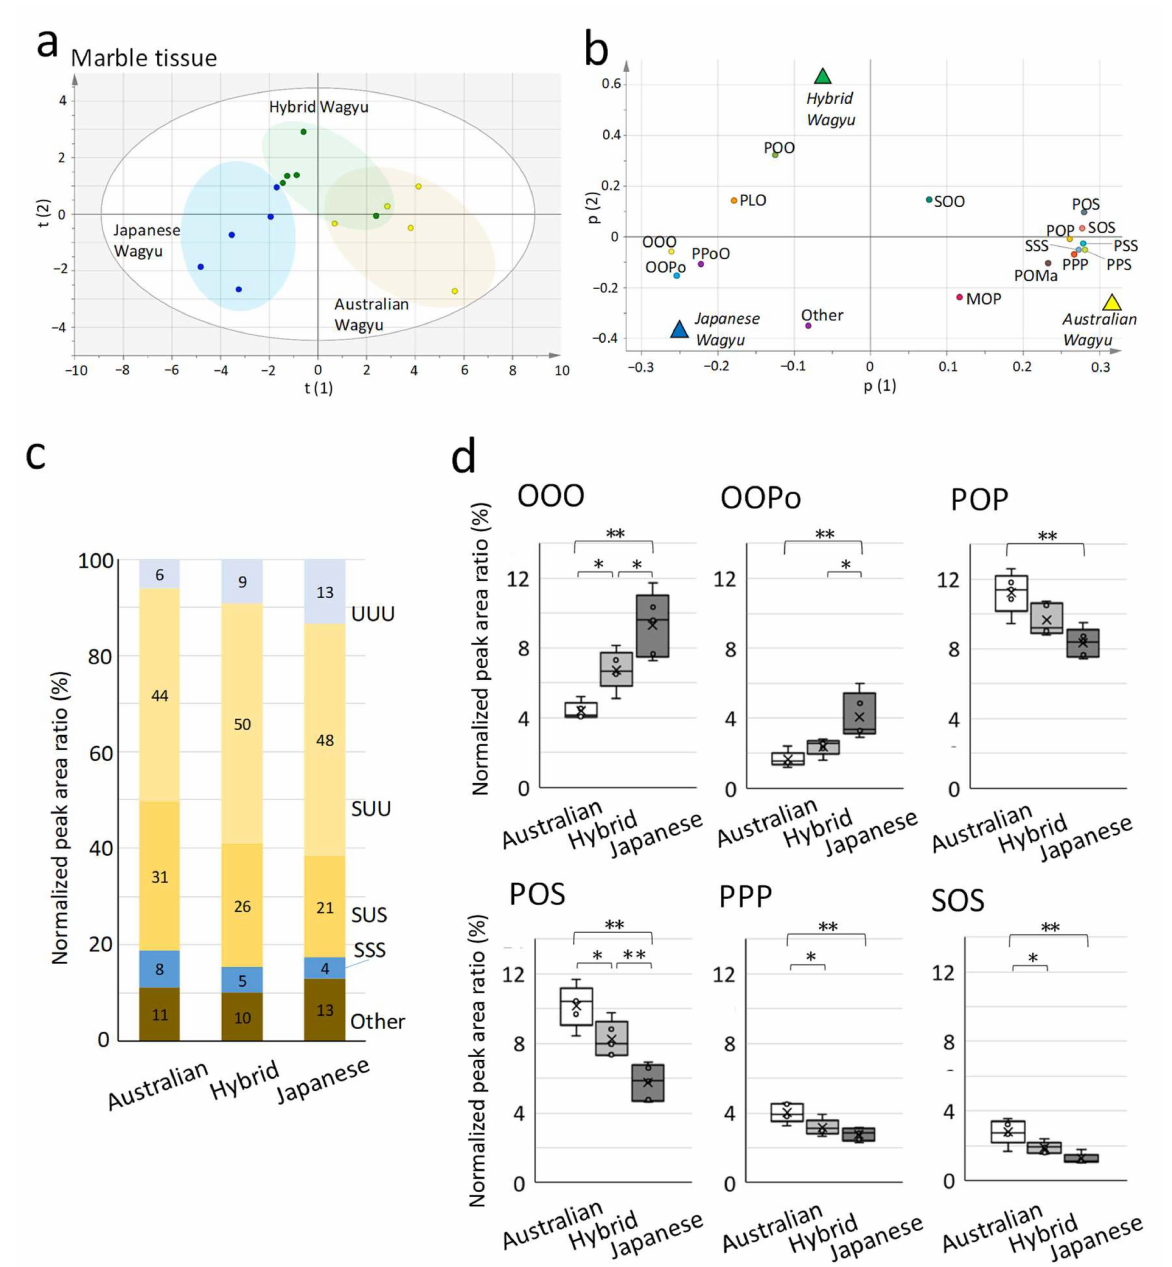
Figure 2. Comparison of triacylglycerides (TG) molecular species among the Wagyu breeds. We used high-performance liquid chromatography to determine the major TGs in Wagyu beef. Marbling tissues from the rib-eye area of the longissimus thoracis muscle (five Australian, five Hybrid, and five Japanese Wagyu) were used. ( a ) The score plot of orthogonal part least-square discrimination analysis (OPLS-DA) illustrated the relationship among Wagyu beef types (scaling, UV). ( b ) Loading plot detailing the relationship between TGs and each Wagyu type (R2X (1) = 0.606; R2X (2) = 0.152). Italicized letters indicate the location of each DA plot (triangles) obtained by OPLS-DA. ( c ) Percentage of unsaturated fatty acids in TGs. Bar graphs present the TG composition of each breed (each Wagyu, n = 5). The three-letter designations indicate the percentage of unsaturated and saturated fatty acids in the TGs. ( d ) Box plot of TGs presenting the exclusive median and all plots, including outliers. The cross marks indicate the mean (n = 5). Significant differences are presented as follows: * p < 0.05 and ** p < 0.01 (Tukey’s test; Australian vs. Hybrid vs. Japanese Wagyu). Abbreviations: U, unsaturated fatty acids; S, saturated fatty